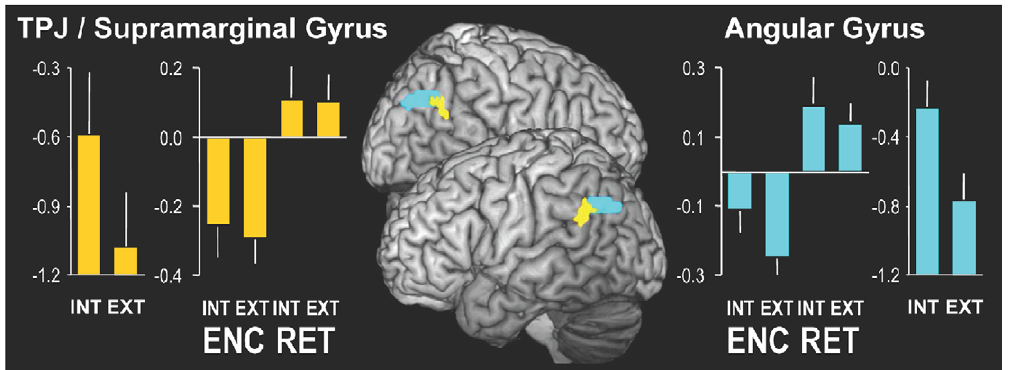
Figure 3. fMRI Results. Direct comparison of two ventral parietal regions: the angular gyrus (ANG – blue) and supramarginal gyrus/temporoparietal junction (TPJ - yellow). Bar graphs indicate mean cluster activity based on the memory-task (averaged over left and right sides. Left bar graphs show activity during encoding for internal (Int) and external (Ext) orienting conditions combined over hits and misses. Right bar graphs reflect the difference in activity between hits and misses for encoding (Int-Enc / Ext-Enc) and retrieval (Int-Ret / Ext-Ret). Vertical lines indicate SEMs.